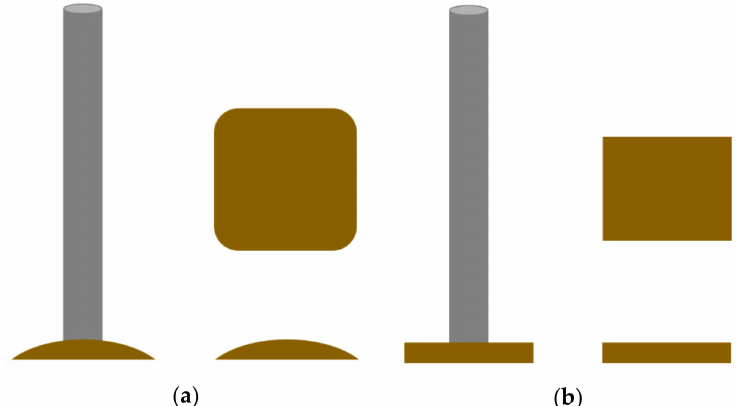
Figure 2. Schematic representation of ( a ) Piston 1 (non-uniform plate height) and ( b ) Piston 2 (uniform plate